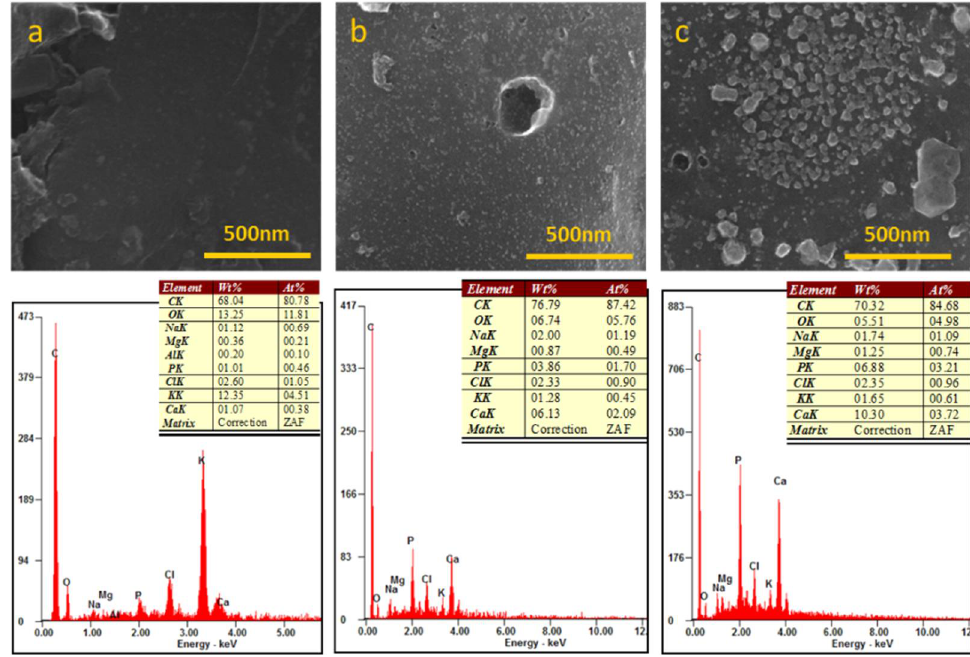
Figure 9. FESEM micrographs and EDX analyses of WDCS750 ( a ) before SBF assay, ( b ) after 1 week in SBF and ( c ) after 4 weeks in SBF. Scale bars (top images): 500 nm